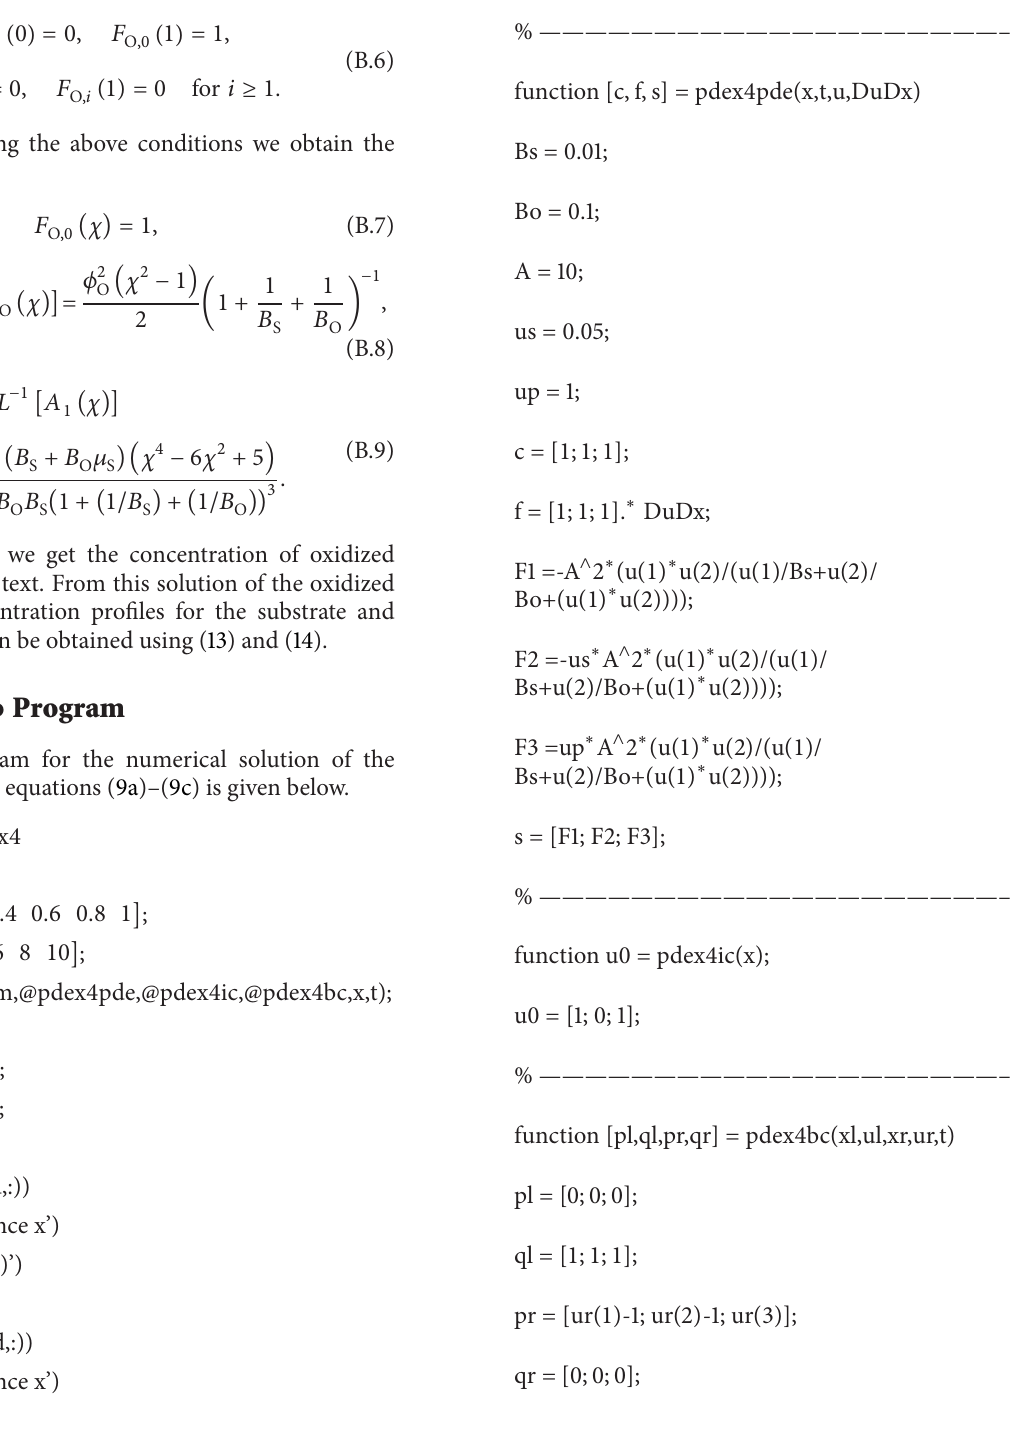
plot(x,u3(end,:)) xlabel(‘Distance x’)